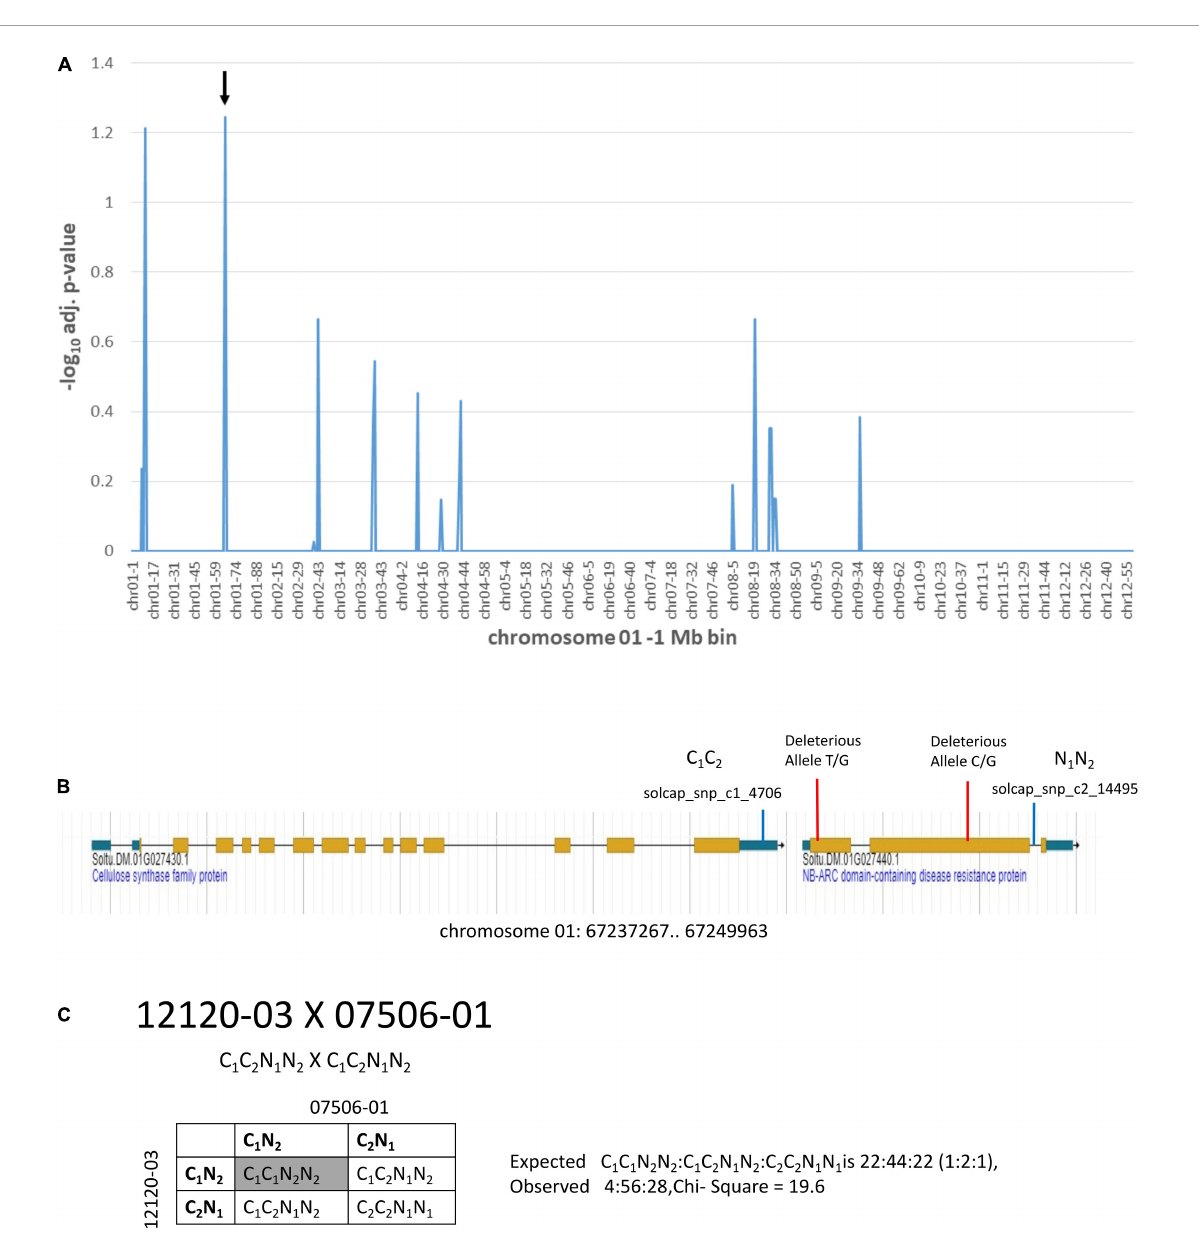
FIGURE6 Segregation distortion on chromosome 1 from a cross of 12120–03 × 07506–01. (A) Markers heterozygous in both parents were tested for deviation from the expected 1:2:1 segregation ratio of progeny using the chi-square test. The y -axis is the –log 10 Bonferroni adjusted p -value from the chi-square test for each of the markers. The x -axis shows the genome divided into 1 Mb bins which is labeled with the chromosome location-bin number. The -log10 adjusted p -value ≥ 1.2 was the threshold for segregation distortion. The arrow indicates the location of the solcap_snp_c2_14495 marker. This marker is in a gene that has two predicted deleterious alleles. (B) The region indicated by the arrow is shown in the DMv6.1 genome browser. (C) Progeny genotypes from a cross of 12120–03 × 07506–01. The solcap_snp_c2_14495 and solcap_snp_c1_4706 markers were adjacent to each other and both showed segregation distortion. The progeny genotype in the gray box has significantly reduced frequency compared to expected.